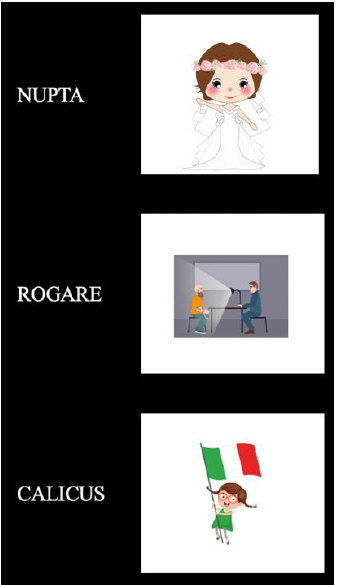
Figure 1. Three distinct examples (noun ( top ); verb ( center ); adjective ( bottom )) as presented in the vocabulary learning phase (VLP).